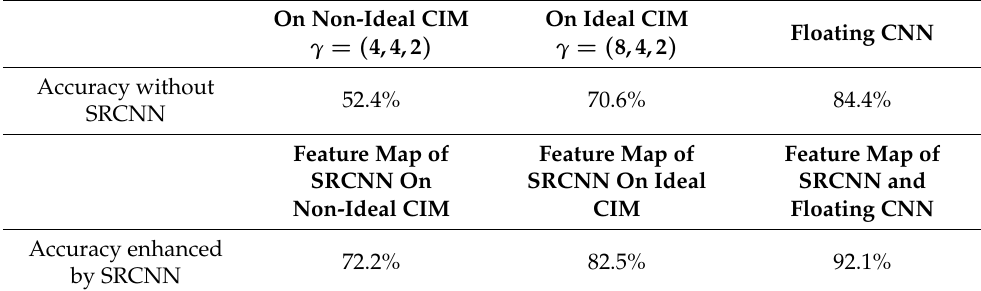
Table 3. The accuracy of five classes classification with SRCNN.